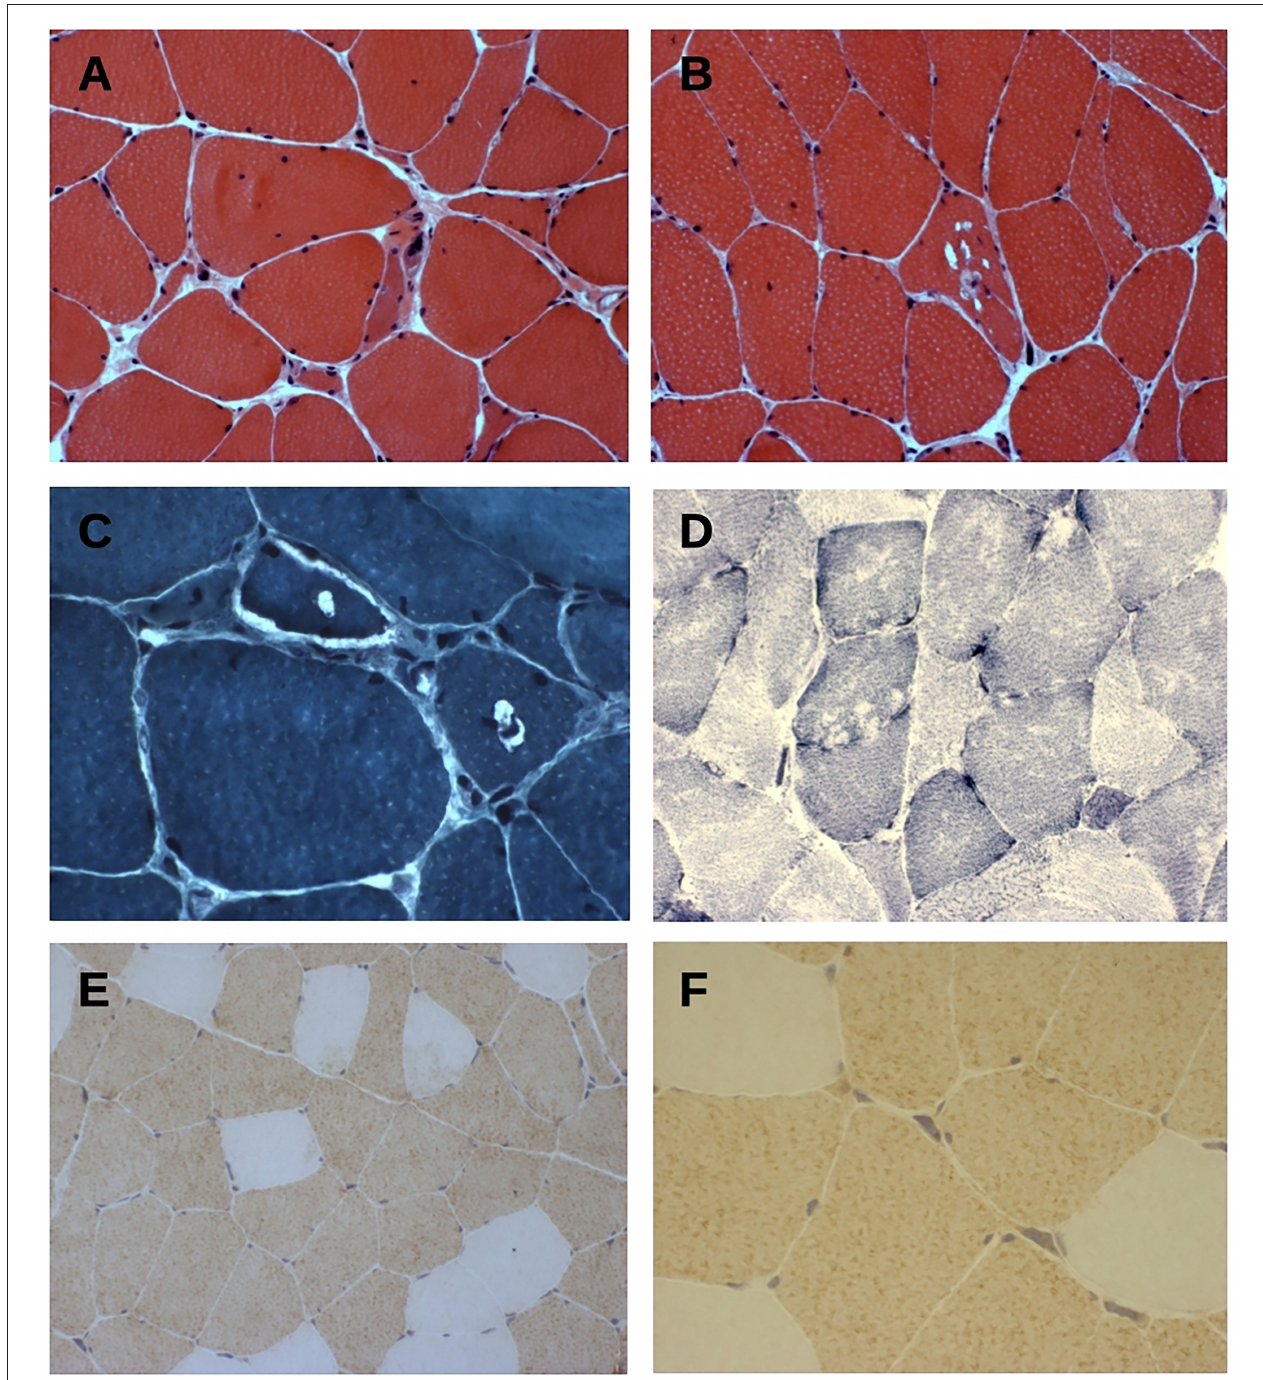
FIGURE 2 | (A–C) Hematoxylin & eosin (A,B) and trichrome Gomori (C) staining of tranverse muscle sections shows fiber size variability, nuclear centralization, and fibers with rimmed-vacuolar changes. Original magnification 200 × (A,B) and 400 × (C) . (D) NADH-TR staining show vacuoles mainly in type 1 fibers. Original magnification 200 × . (E,F) Fast myosin heavy chain (MyHCfast) immunostaining shows a type 2 fiber predominance, a variation in fiber size, and some MyHCfast-positive nuclear clumps. Original magnification 200 × (E) and 400 × (F) .